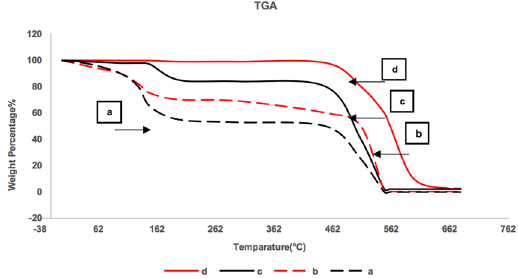
Figure 4. TGA curves of ( a ) GO, ( b ) r-GO-31, ( c ) r-GO-19, ( d ) r-GO-9.